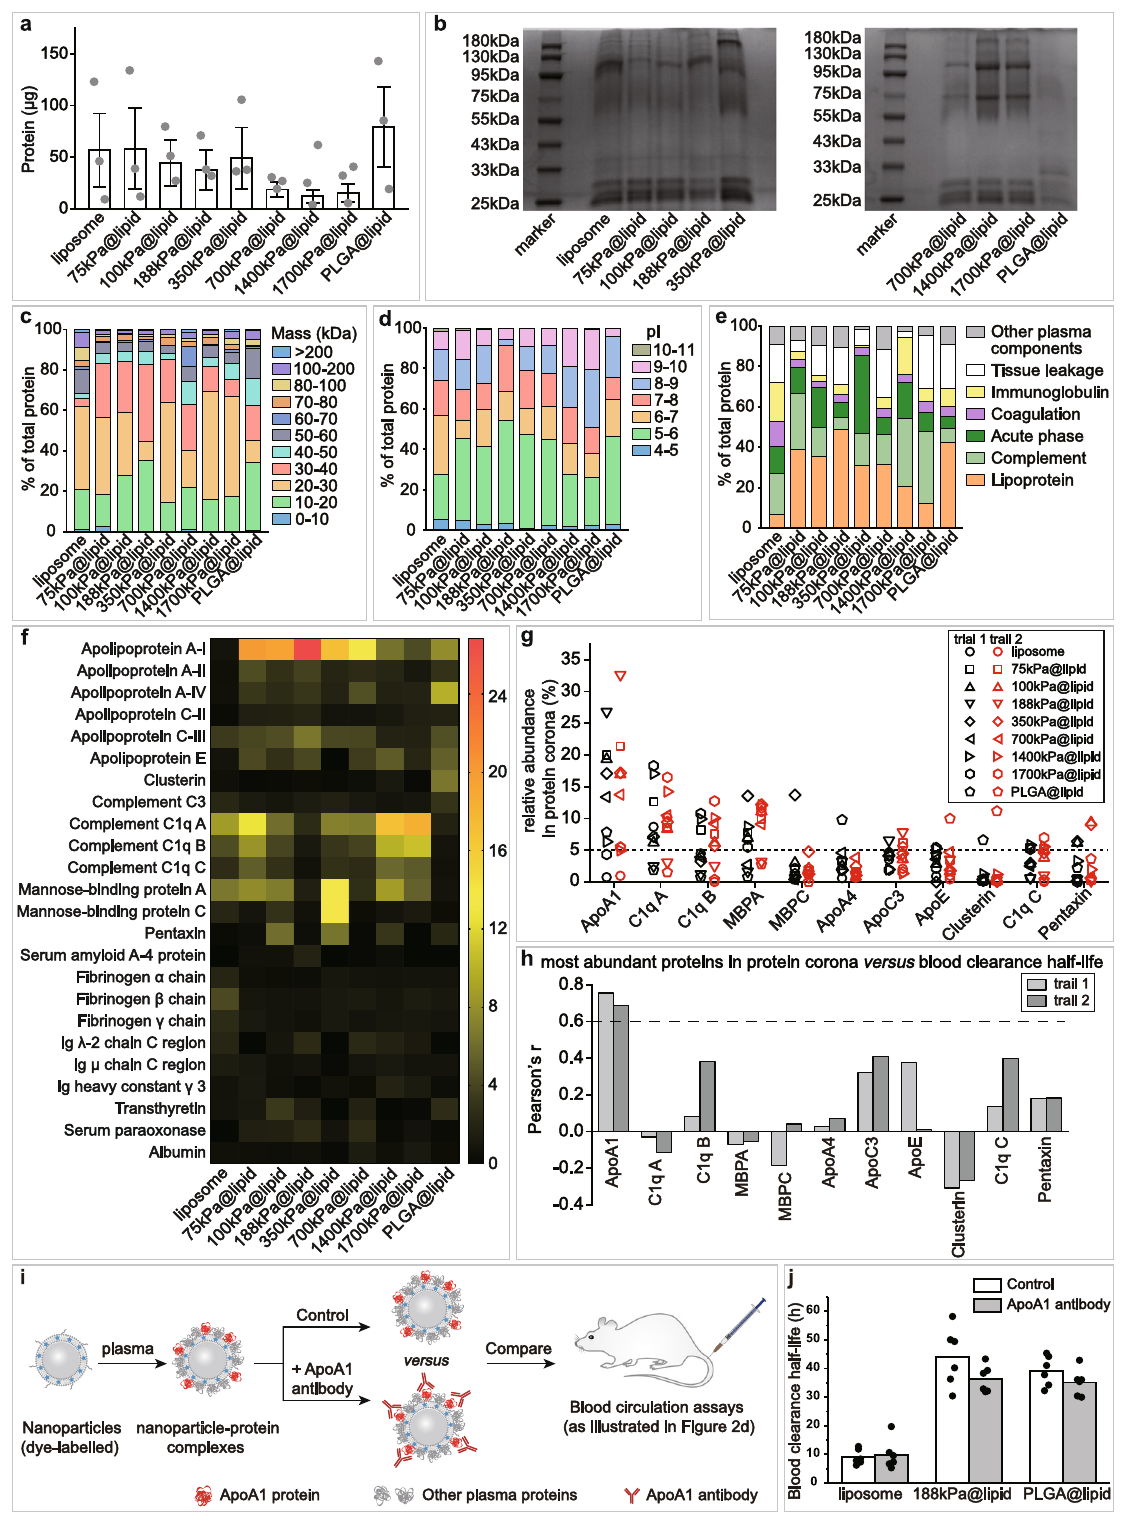
44 h to 36 h in average blood clearance half-life (relatively by three model nanoparticles, their order of relative change in blood ~18%) due to the shielding of adsorbed ApoA1 by ApoA1 clearance half-life (0% for liposome, 10% for PLGA@lipid, and antibody. For PLGA@lipid, the pre-treatment with ApoA1 ~18% for 188 kPa@lipid) nicely mirrors their ranks of ApoA1 antibody appreciably shortened the complex ’ s blood clearance abundance in corona (~0% for liposome, ~8% for PLGA@lipid, half-life (from 39 h to 35 h in average blood clearance half-life) and ~25% for 188 kPa@lipid) (Fig. 3f). Clearly, shielding/screen- (Fig. 3j) but to a less extent than the case with 188 kPa@lipid ing the adsorbed ApoA1 in corona over a nanoparticle shortens (relative reduction of ~10% versus ~18%). Interestingly, for these the particle ’ s blood circulation lifetime and the relative extent of NATURE COMMUNICATIONS| (2022) 13:4137 |https://doi.org/10.1038/s41467-022-31882-4|www.nature.com/naturecommunications